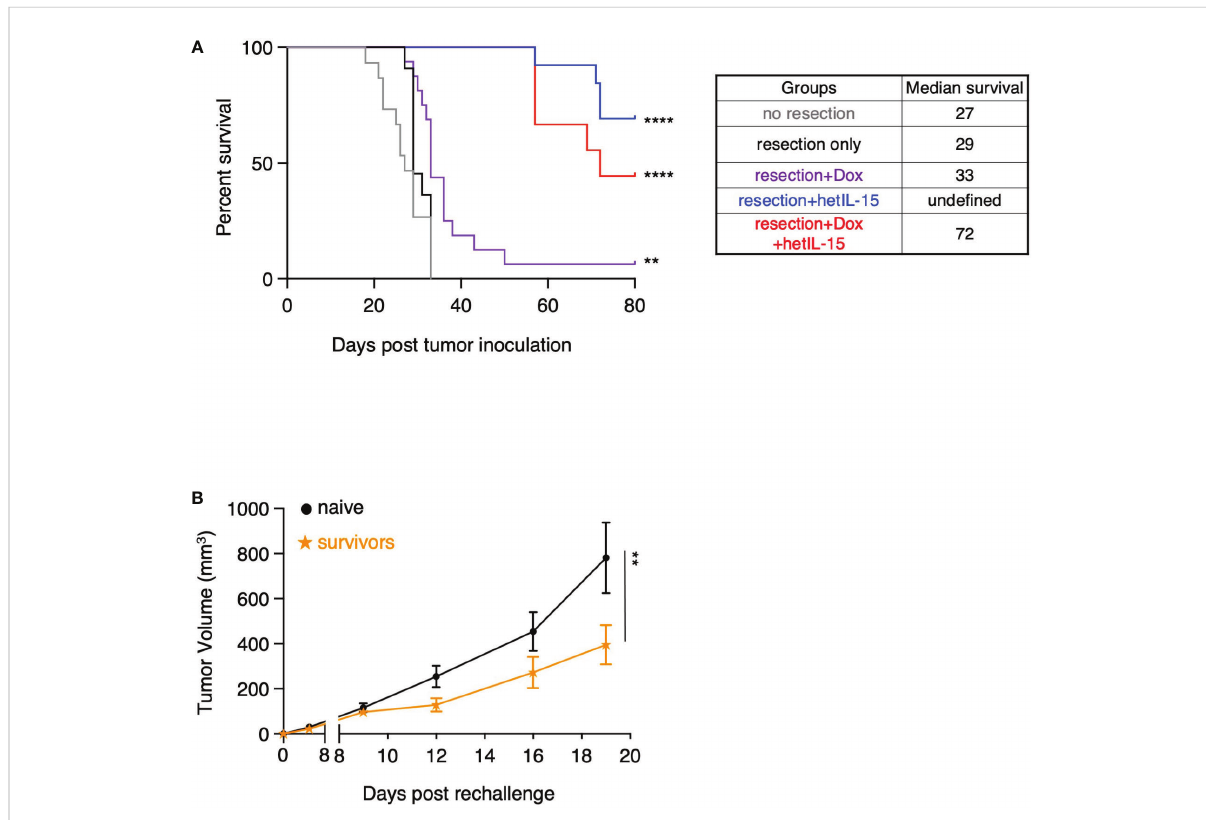
FIGURE 6 hetIL-15 alone or in combination with doxorubicin cures the resected mice and facilitates the development of tumor-speci fi c immunological memory. (A) Survival curves for the animals in each experimental group. Mice were resected and treated following the therapeutic schedule shown in Figure 5A. Data merged from two independent studies (n=9-16). Statistical analysis was done by Log-rank (Mantel-Cox) test. (B) Tumor growth curves of naive and survivor animals [hetIL-15 and combination group mice merged from (A)] after rechallenge with 5x10 4 4T1 cells without any treatment until day 19. Tumor volume (mm 3 ) ± SEM for each time point is shown. Statistical analysis was done by two-way ANOVA (n=9-10). ** p < 0.01, **** p < 0.0001, SEM, standard error of the